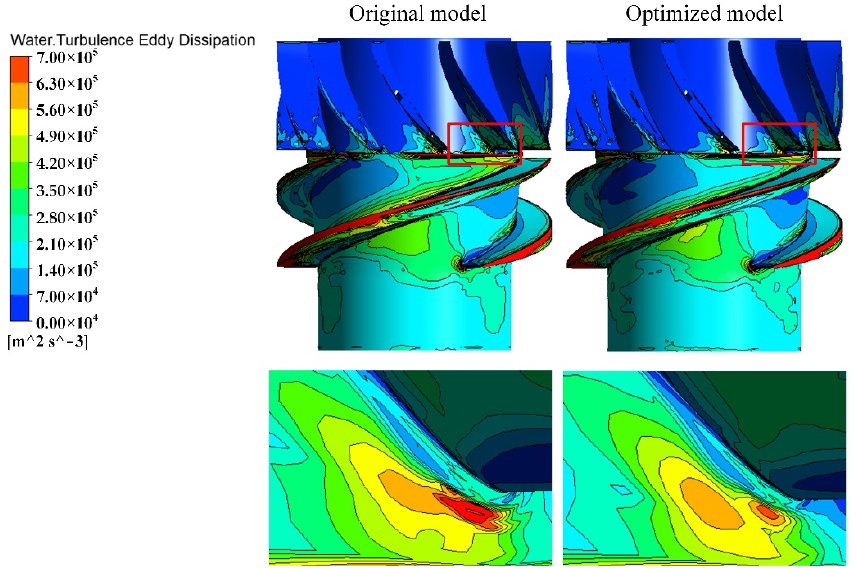
Figure 16. Distribution of turbulent energy dissipation rate under the 20%GVF condition.